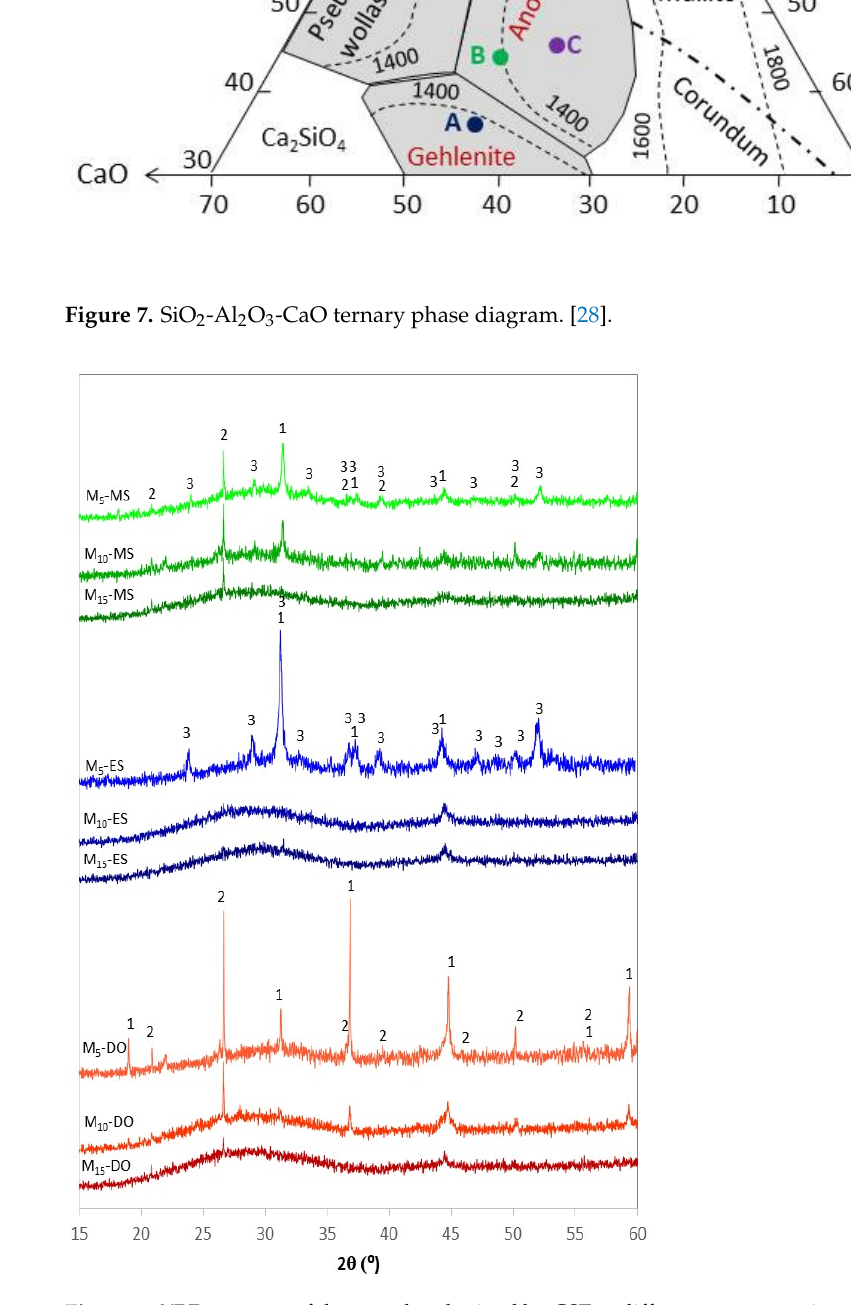
Figure 8. XRD patterns of the samples obtained by CSE at different treatment time. (1: MgAl 2 O 4 spinel, ICDD 01-086-0085; 2: SiO 2 quartz, ICDD 01-083-0539; 3: Ca 2 Al 2 SiO 7 gehlenite, ICDD 01-079- 1726).